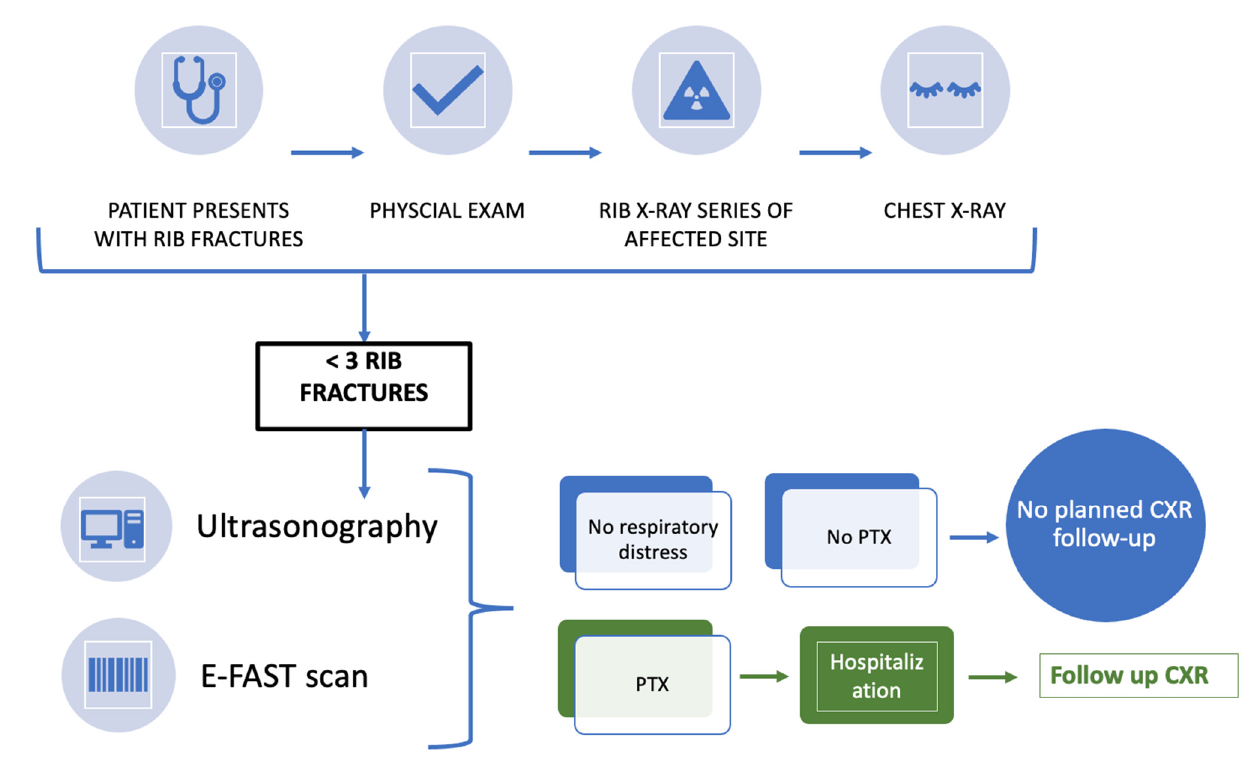
Figure 2. Flow chart of minor chest trauma presenting fewer than three rib fractures. PTX = pneu- mothorax; CXR—chest X-ray. orax; CXR—chest